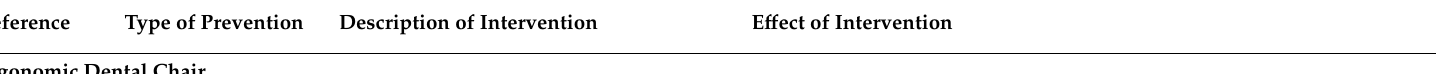
Table 3. Ergonomic interventions and their e ff ects in the included studies reporting ergonomic interventions to prevent MSDs among dental professionals ( n =